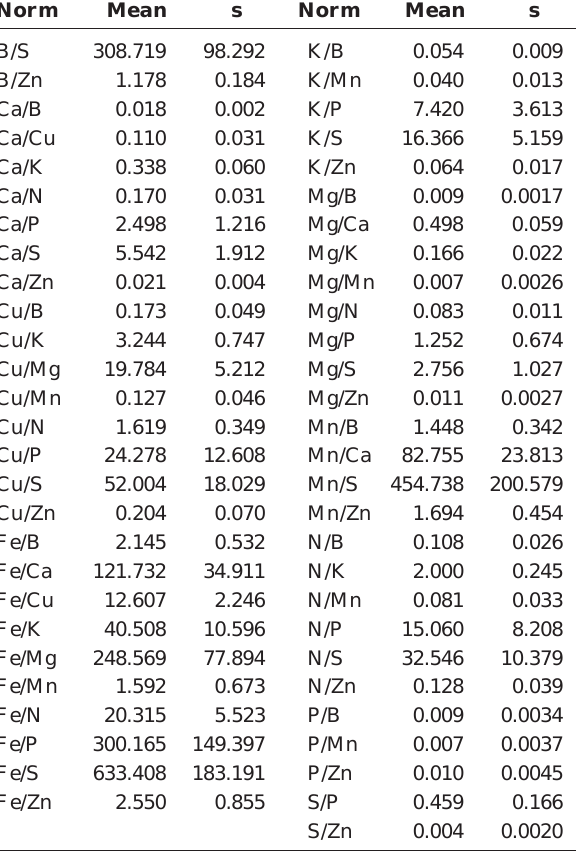
Table 2. Mean and standard deviation (s) of binary ratios between leaf nutrient contents (R2 stage) in soybean plants for the subpopulation with high (1) seed oil content (DRIS Norms). 2007/08 growing season